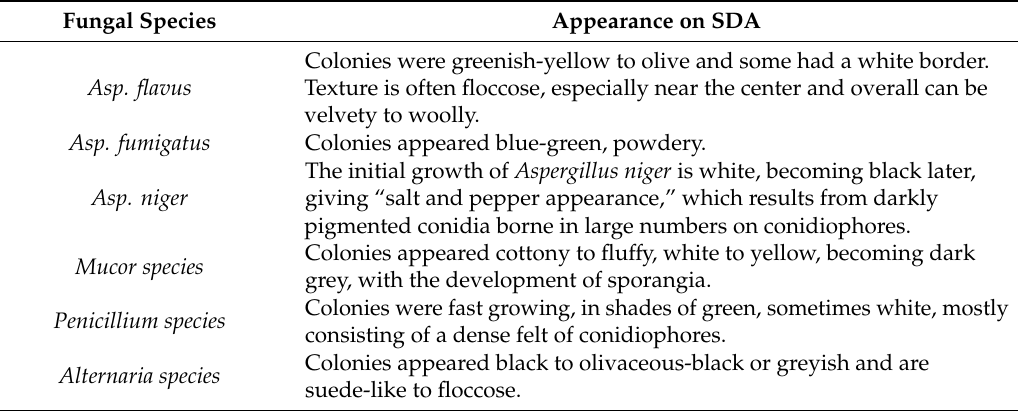
Table 1. The morphology and characters of colonies on agar, the colonies of the di ff erent species of fungi, and their appearance on Sabouraud dextrose agar media